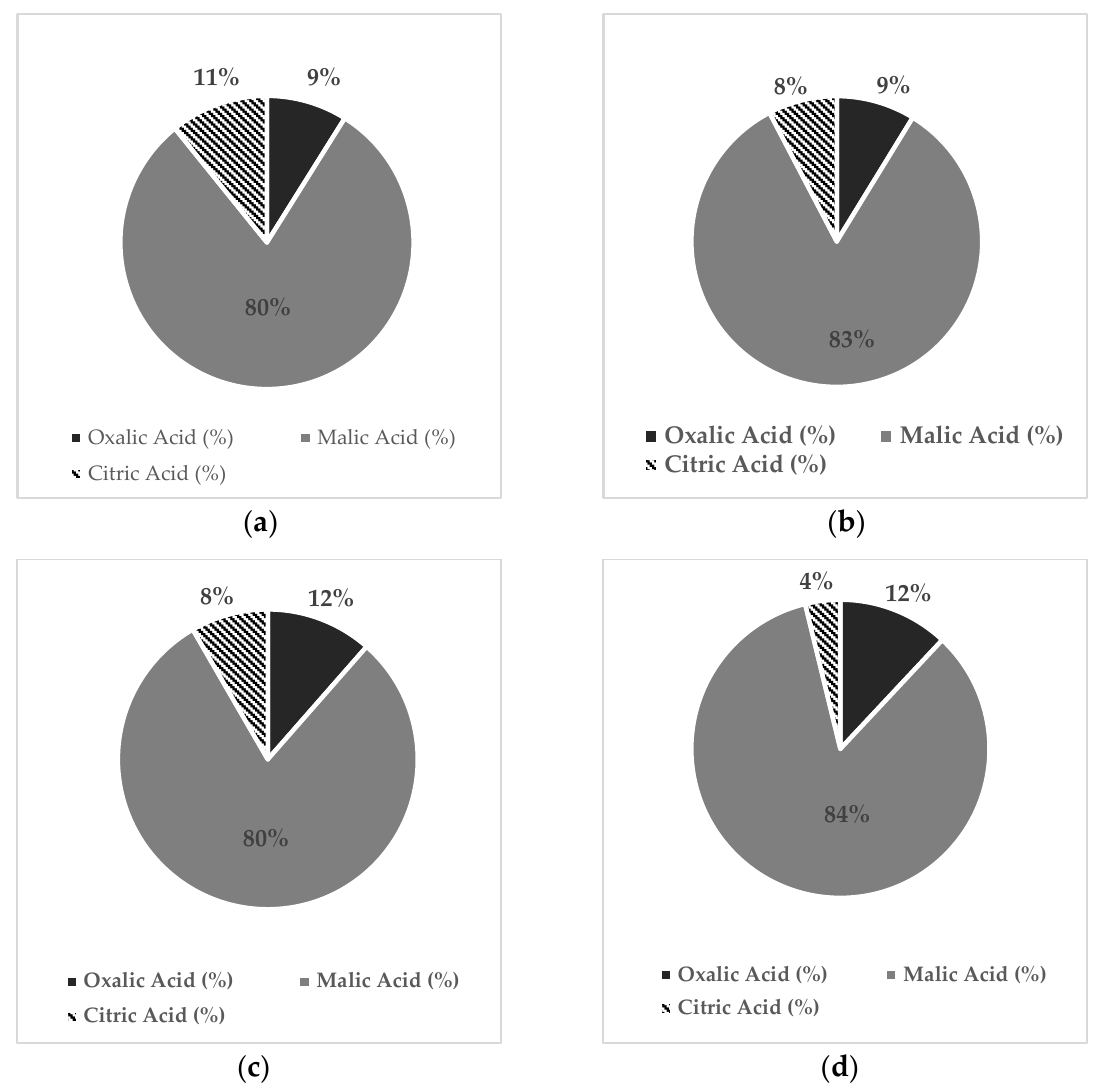
Means ± standard errors (SE) are shown. Statistically significant differences between treatments for each canopy zone are represented by different lowercase letters (horizontally), based on the LSD Fisher multiple range test ( p ≤ 0.05 ).